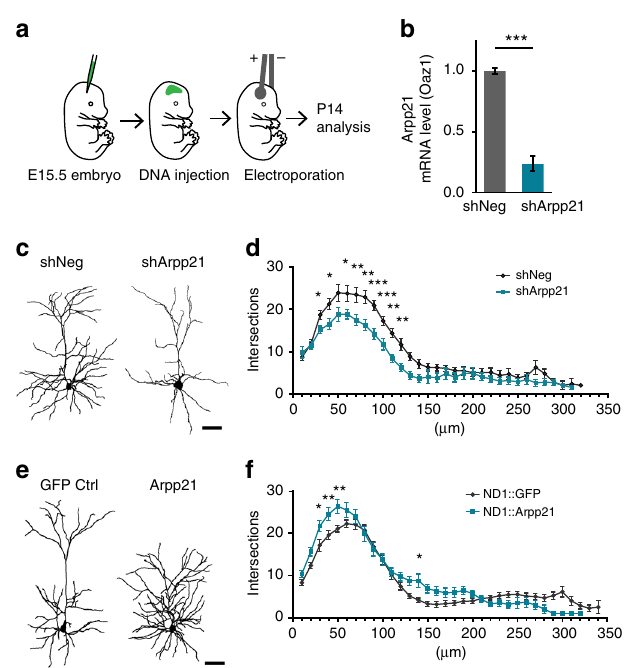
Fig. 7 Phenotype of ARPP21 loss- and gain-of-function during cortical neuron differentiation in vivo. a IUE at E15.5 with Arpp21 shRNA or overexpression constructs followed by morphological analysis at